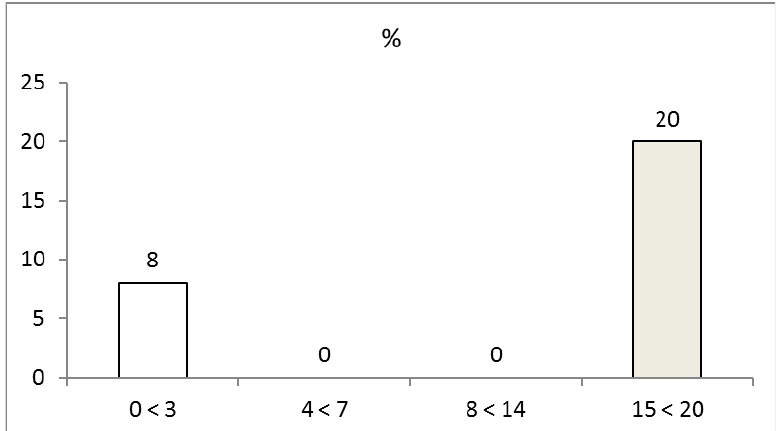
Figure 4. The injury rate depending on the experience of skiing